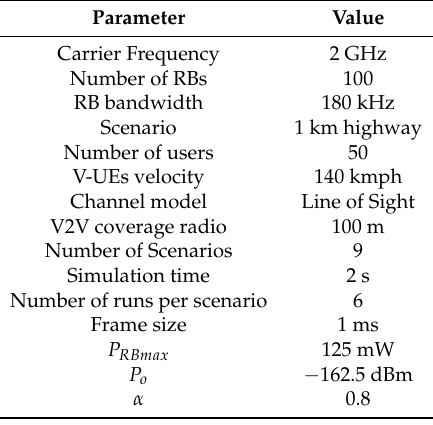
Table 1. Simulation